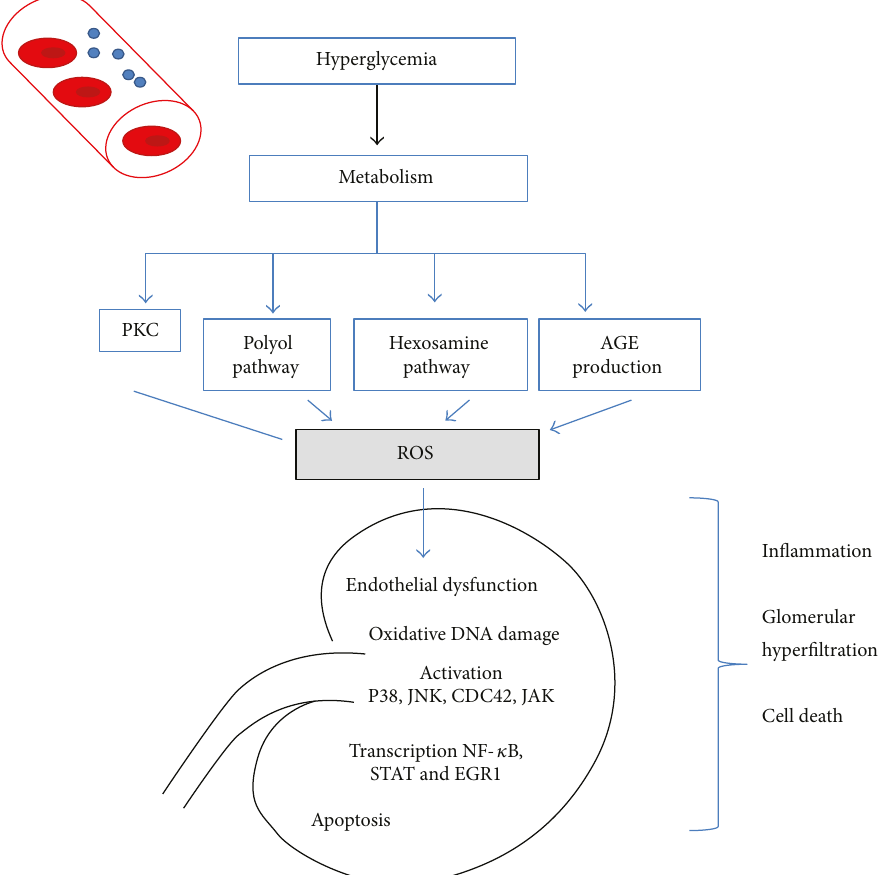
Figure 2: Hypothetical drawing of the apoptotic process in DN from hyperglycemia. Di ff erent signaling pathways that are activated in the state of hyperglycemia lead to OS and in fl ammation with capacity to carry out apoptosis in susceptible